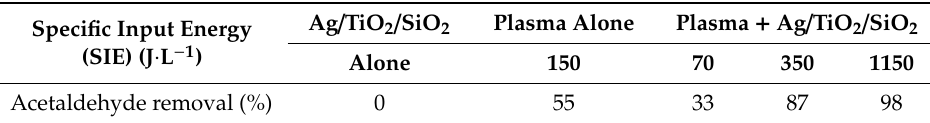
Table 1. Acetaldehyde removal obtained using the plasma-driven catalysis and the non-thermal plasma (NTP) processes.